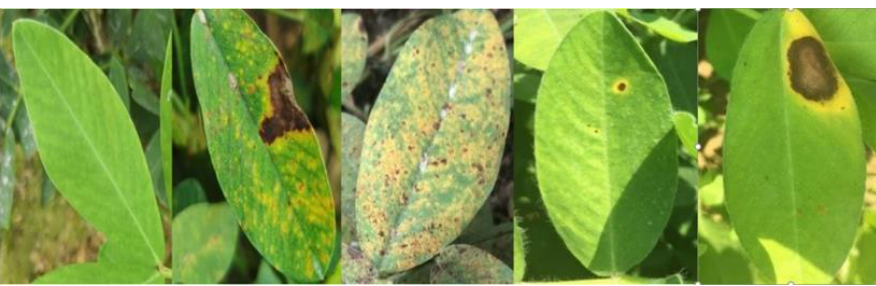
Figure 2. Condition of leaves, from left to right: healthy, simultaneously suffering from rust and scorch disease, rust disease, leaf-spot disease, and scorch disease.